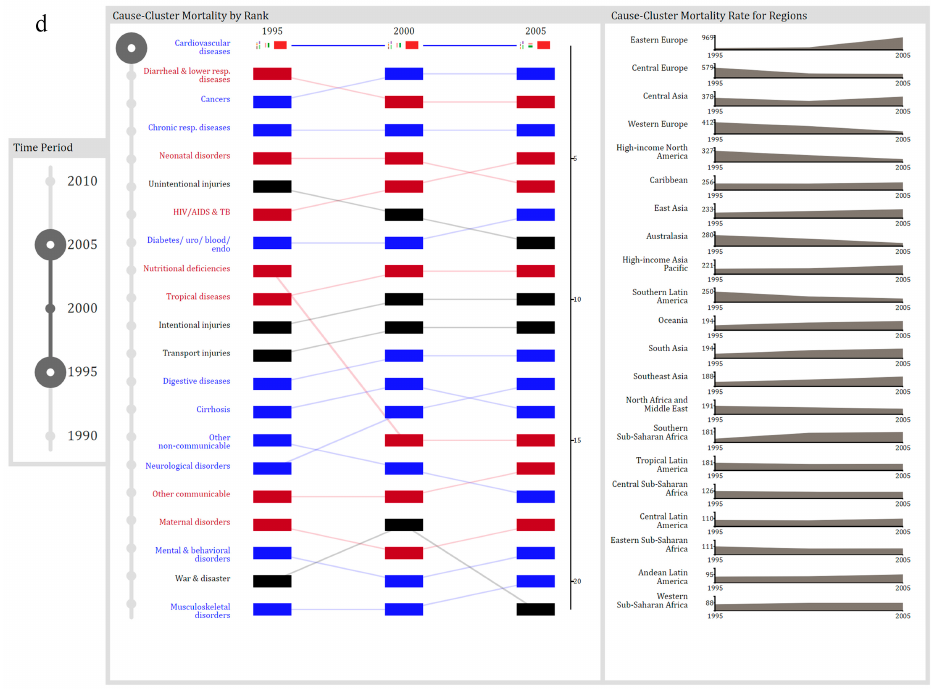
Figure 12. ( a ) First panel of chronology visualization with neurological disorders selected; ( b ) first panel of visualization with cirrhosis selected; ( c ) Third panel collapsed and the time frame changed to 1990–2005 and digestive disorders selected; ( d ) Second panel collapsed and time changed to 1995–2005 and cardiovascular cluster selected.